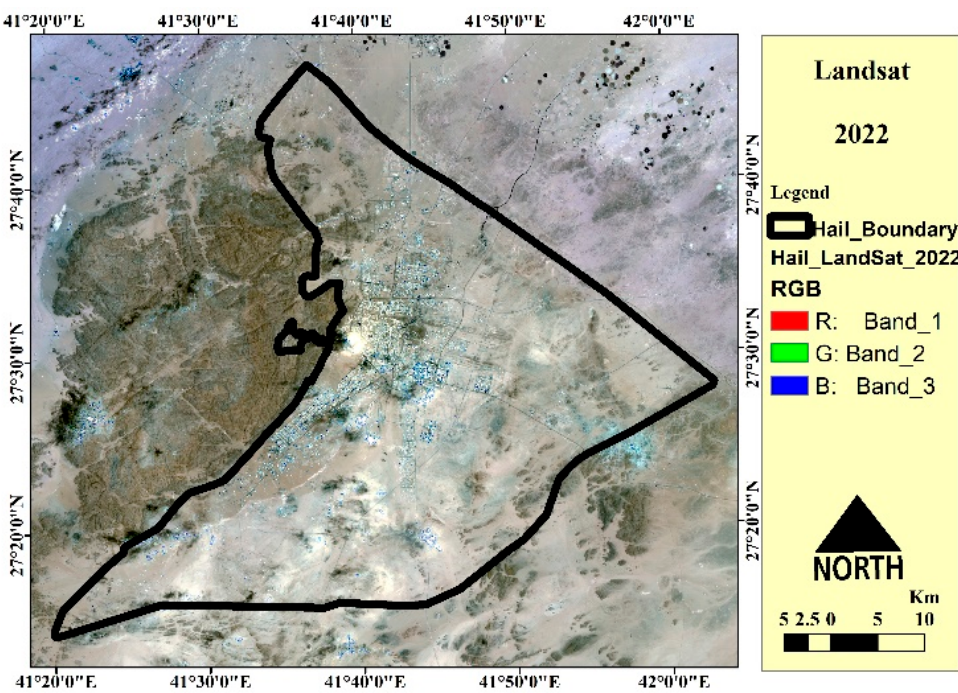
Figure 7. Satellite image (Landsat 2022) for the study area.